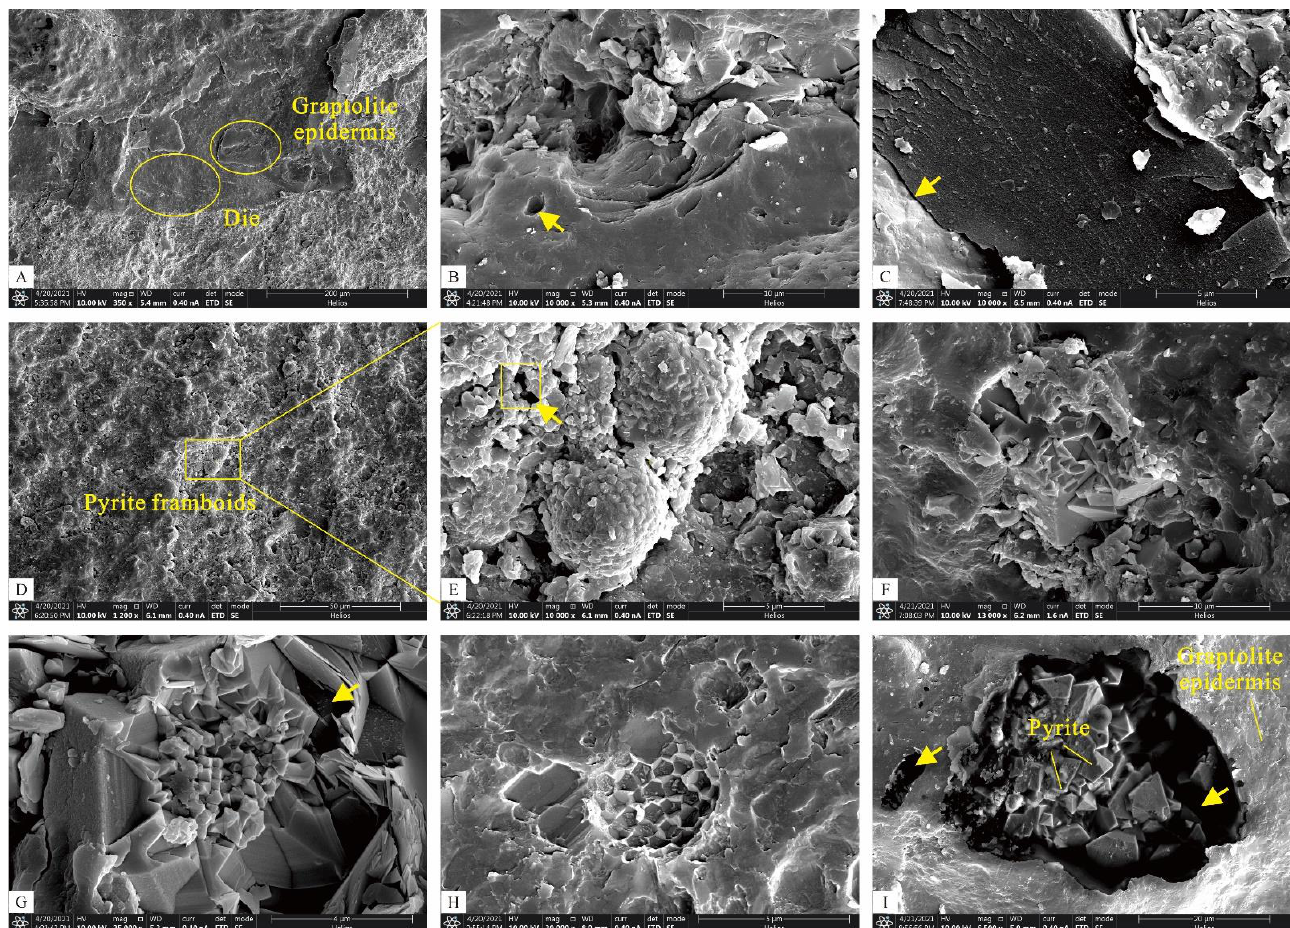
Figure 4. SEM image of graptolite shale. ( A ) layered structure and die of graptolite epidermis; ( B ) layered structure and organic pores of graptolite epidermis. The arrow points to the hole, and it is the same below; ( C ) fusellal fabric on the fresh section of graptolite epidermis and crevice; ( D ) large amount of pyrite framboids; ( E ) pyrite framboids and intergranular pores of pyrite; ( F ) euhedral pyrite. ( G ) Pyrite is associated with clay minerals and produces intergranular pores. ( H ) the impression on the graptolite epidermis after pyrite framboid removal; ( I ) graptolite cavity filled with py- rite.